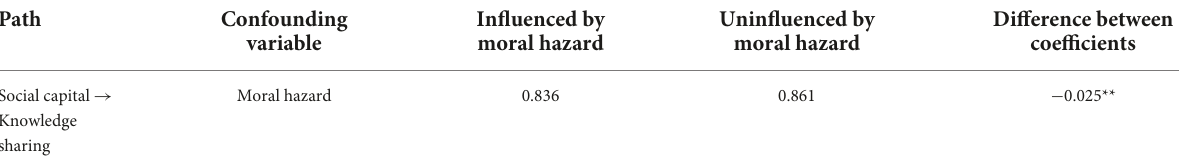
TABLE 7 Path analysis of the moderating variable.